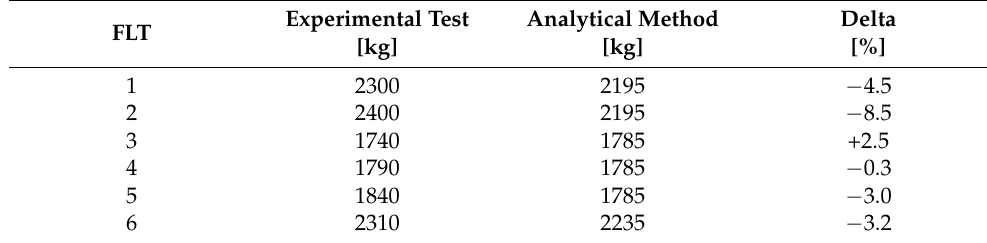
Table 1. Comparison between experimental tests and analytical procedure for lateral displacement.